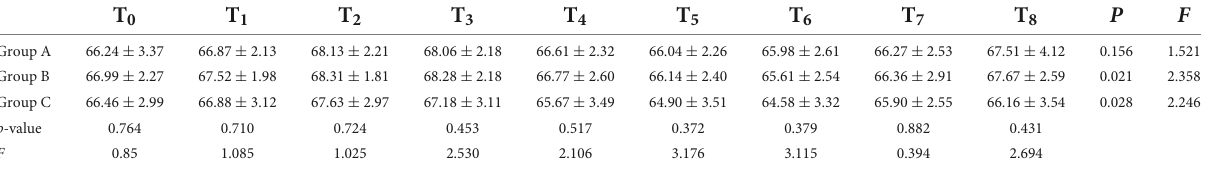
TABLE 2 Changes in rSO 2 at various time points among the three groups.